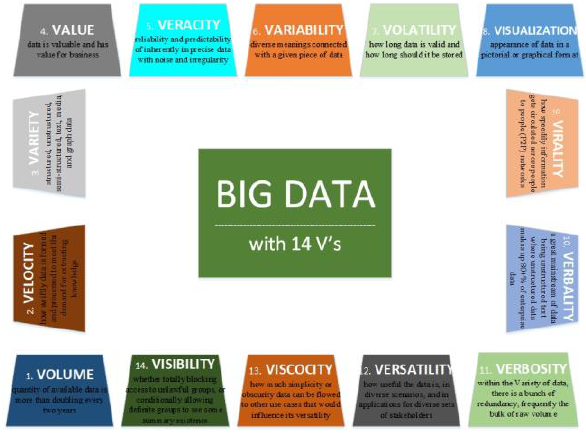
Figure 1: Big Data technology with 14